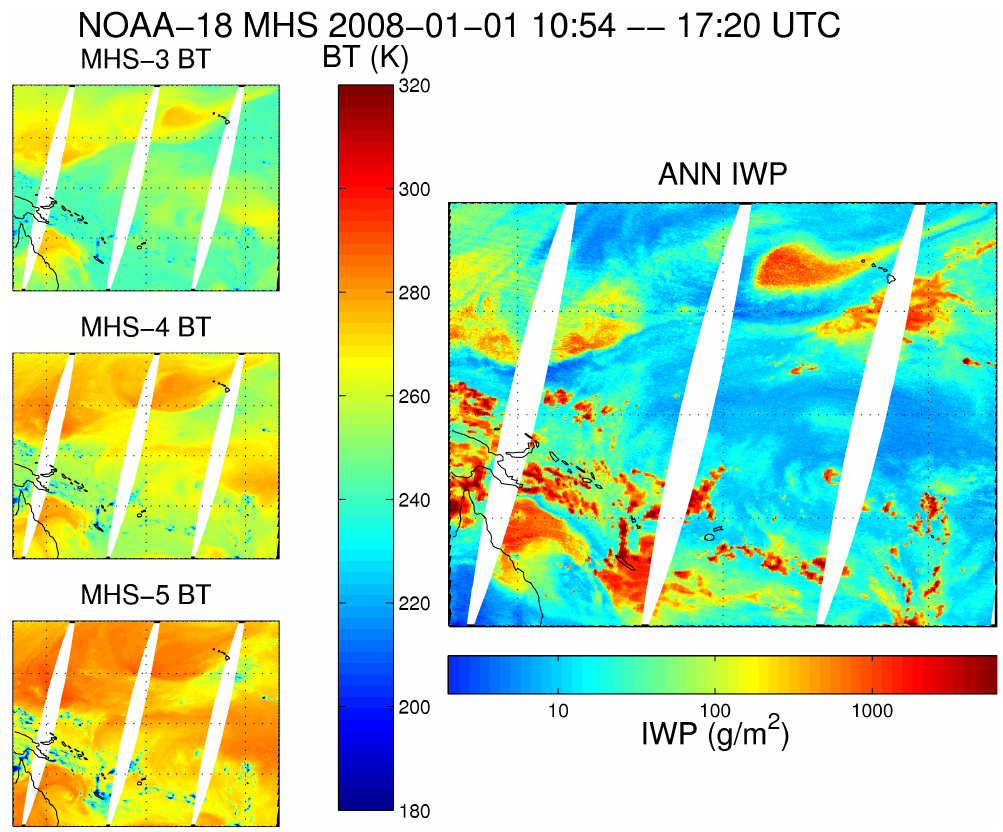
Fig. 9. The neural network (see text) can be used to retrieve IWP from radiances. The figure shows observations by NOAA-18 in the descending node on 1 January 2008 between 10:54 and 17:20UTC (local time during the night). The left panels show the brightness temperatures as observed by the MHS channels 3–5. The right panel shows the IWP as generated with the neural network as described in the text. Cold areas in the left panel correspond to wet areas in the right